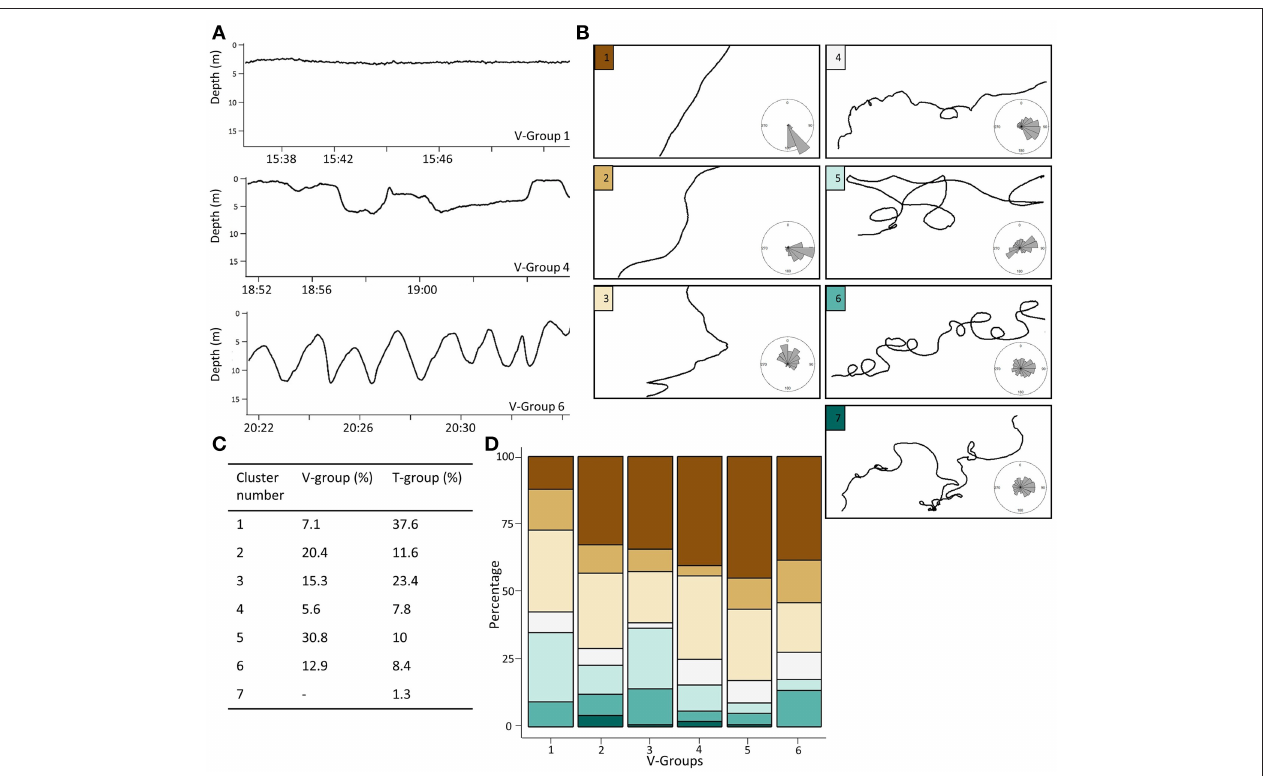
FIGURE 2 | Comparison of dominant vertical movement clusters (V-groups) and path tortuosity clusters (T-groups) from hierarchical cluster analysis. (A) 15min depth profiles representative of V-groups 1, 4, and 8, demonstrating the increase in oscillatory movements with V-group. (B) 5–15min pseudo-tracks representative of each T-group, demonstrating the increase in tortuosity with T-group. Each pseudo-plot is displayed in approximately the same amount of area, resulting in directional tracks moving outside of the given area after 5min. As constant speed was used to estimate pseudo-tracks, we caution that speed changes throughout these windows by tagged sharks may slightly influence the shape of resulting pseudo-tracks. Polar plot on bottom right of each track displays example of heading variance for each group over the entire 15min window. (C) The % windows found in each cluster. (D) The % T-group composition of each dominant V-group. Colors are T-groups from (B)